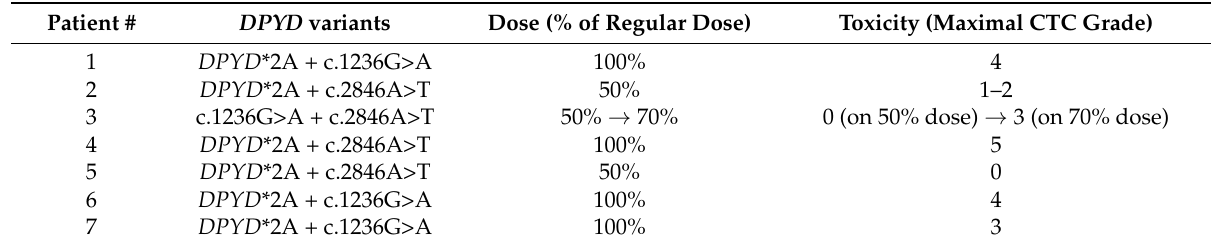
Table 3. Toxicity profiles of compound heterozygous DPYD variant allele carriers. Shown per patient are DPYD variants, fluoropyrimidine dose as a percentage of the regular dose, and experienced toxicity with this dose. All patients retrospectively identified as DPYD variants carrier received full doses and experienced severe (CTC-AE ≥ 3) toxicity. All patients prospectively identified as DPYD variant(s) carrier received dose reductions and experienced a maximum of CTC-AE grade 2 toxicity with the initial dose. Abbreviations: CTC-AE: Common Terminology Criteria for Adverse Events v4.03.